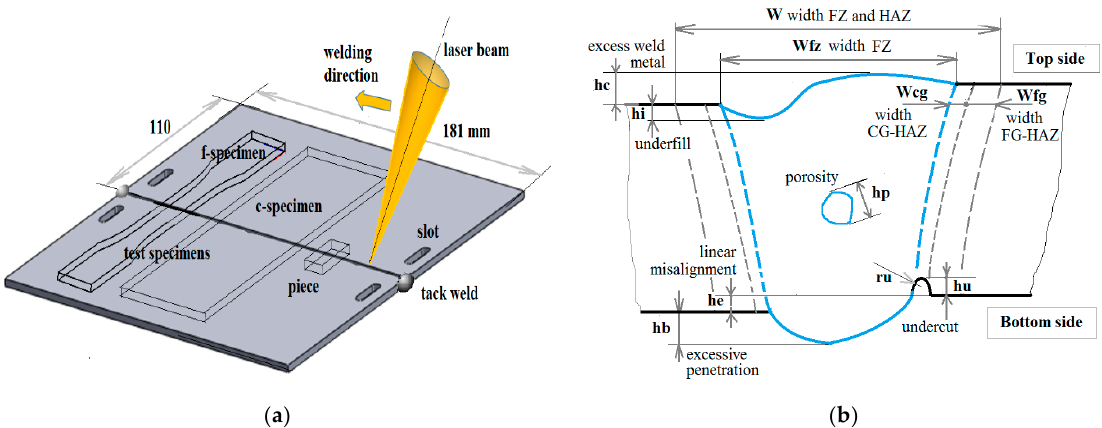
Figure 1. Schemes of: ( a ) the welded sample; ( b ) the weld bead with designations of typical imperfections and zones produced by welding.